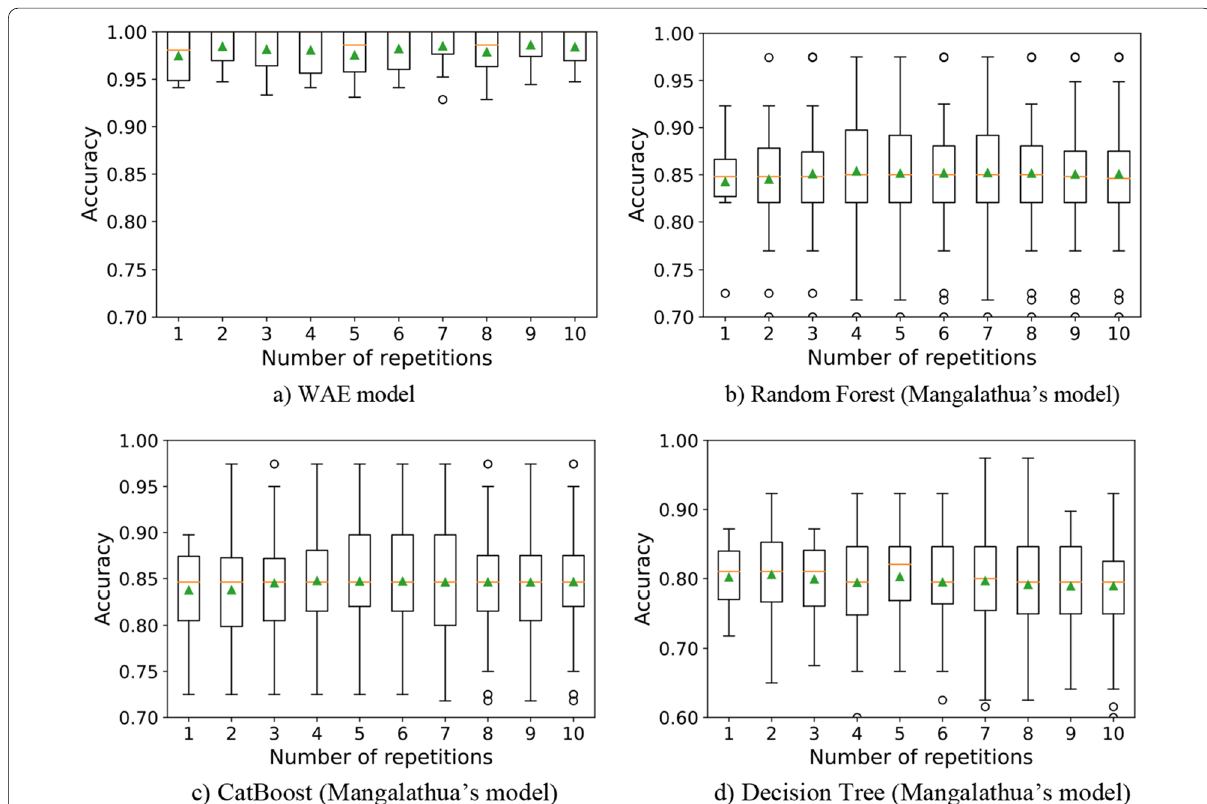
Fig. 10 Box and Whisker plots of accuracy. a WAE model. b Random Forest (Mangalathua’s model). c CatBoost (Mangalathua’s model). d Decision Tree (Mangalathua’s